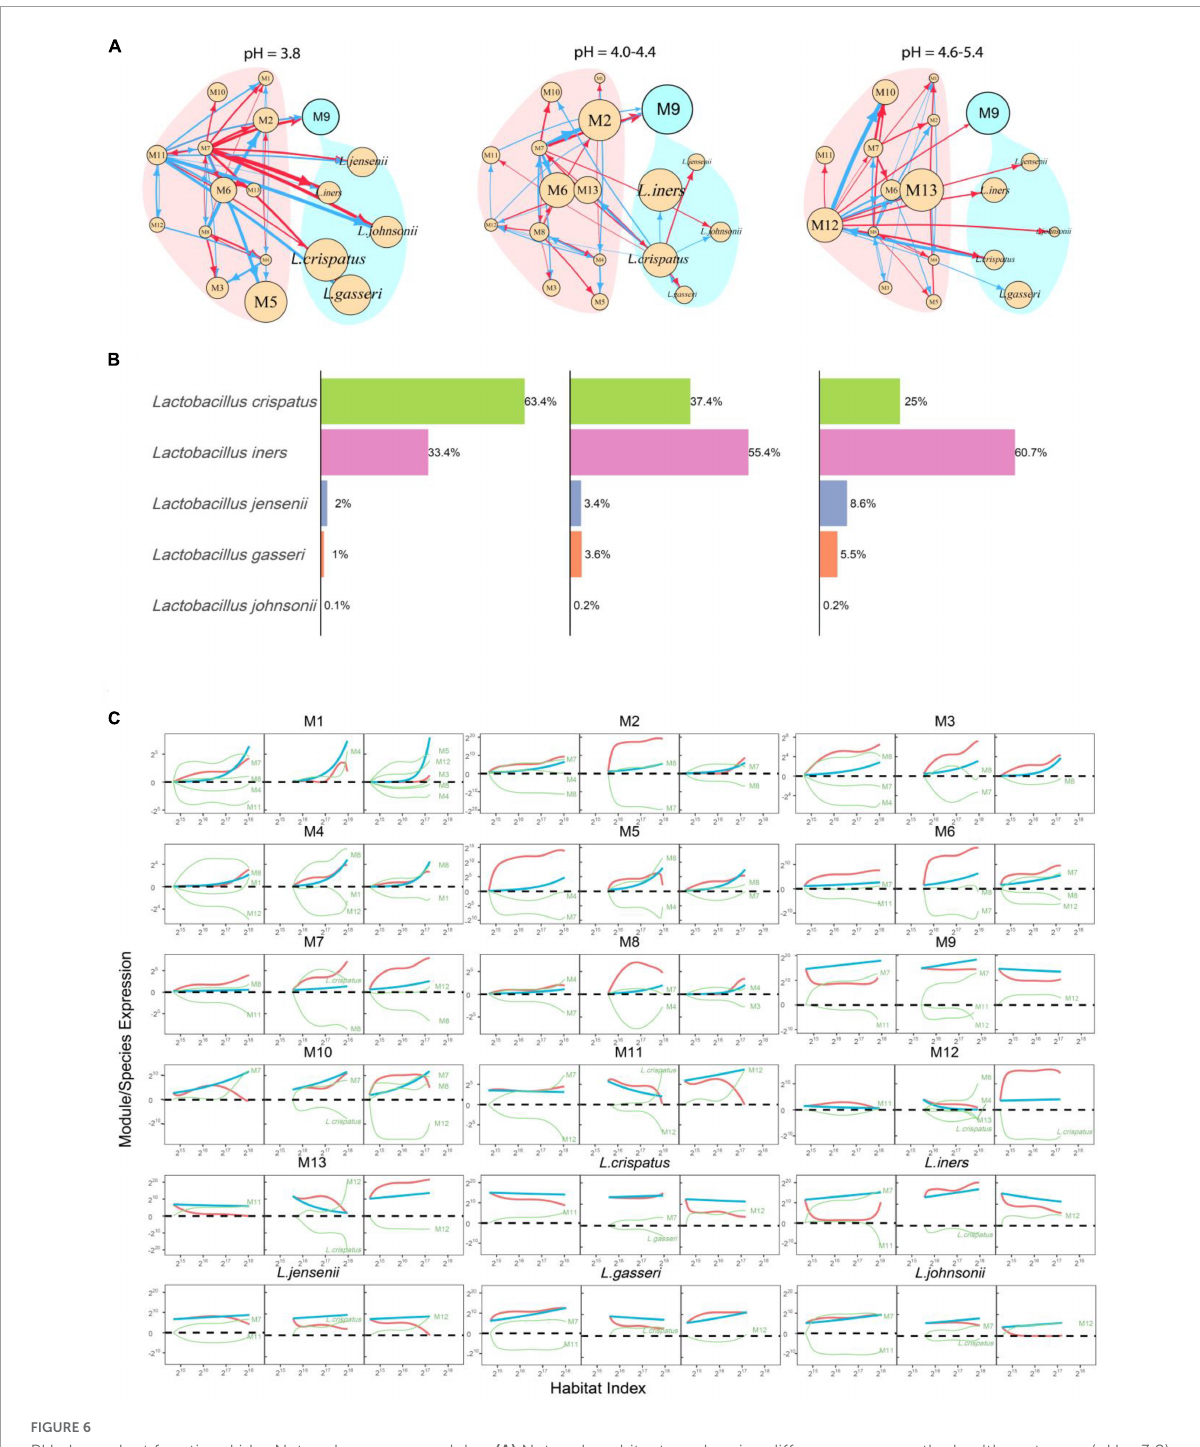
FIGURE6 PH-dependent functional idopNetworks among modules. (A) Network architecture showing differences among the healthy category (pH = 3.8), the sub-healthy category (pH = 4.0–4.4), and the AV category (pH = 4.6–5.4). Genus Lactobacillus is the only module contained in module M9, whose five most abundant species are added into the network. Red and blue lines denote promotion and inhibition, respectively, with line thickness proportional to the strength of interactions. (B) The percentages of abundance of the five most abundance species of Lactobacillus in this genus in three pH categories. (C) Decomposition of the net abundance trajectory (blue line) of each module into its independent abundance trajectory (red line) and dependent abundance trajectory (green line) in the healthy category (left panel), the sub-healthy category (middle panel), and the AV category (right panel). The names of modules that regulate a given module are shown in the plot (positive regulators above the zero line and negative regulators above the zero